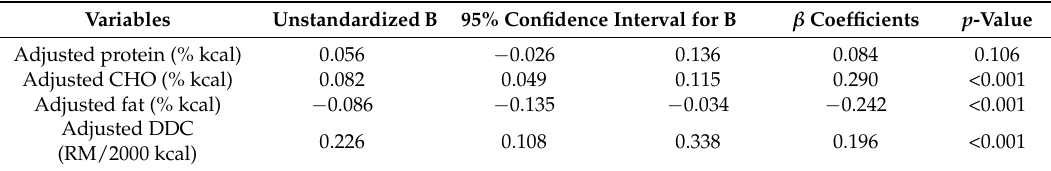
Table 4. Determinants of diet quality from a multiple linear regression model.